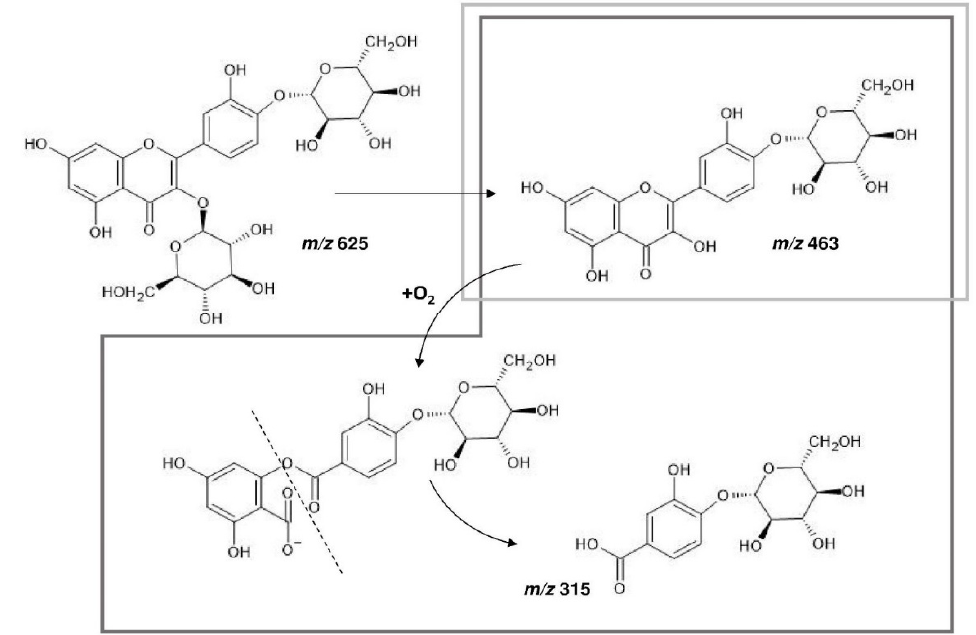
Figure 4. Proposed degradation pathway for quercetin-3- O -hexoside-4 (cid:48) - O -hexoside during cooking of YSO and RSO. Quercetin-3- O -hexoside-4 (cid:48) - O -hexoside ( m/z = 625) was firstly de-glycosylated at the C3 level, releasing quercetin-4 (cid:48) - O - hexoside ( m/z = 463), under heating treatment and in presence of oxygen. Quercetin-4 (cid:48) - O -hexoside may face the nucleophilic attack by oxygen and the cleavage of the C-ring, resulting in the release of protocatechuic acid-hexoside ( m/z = 315). Light grey box records the hypothesized degradation pathway detected in YSO. Dark grey box records the hypothesized degradation pathway detected in